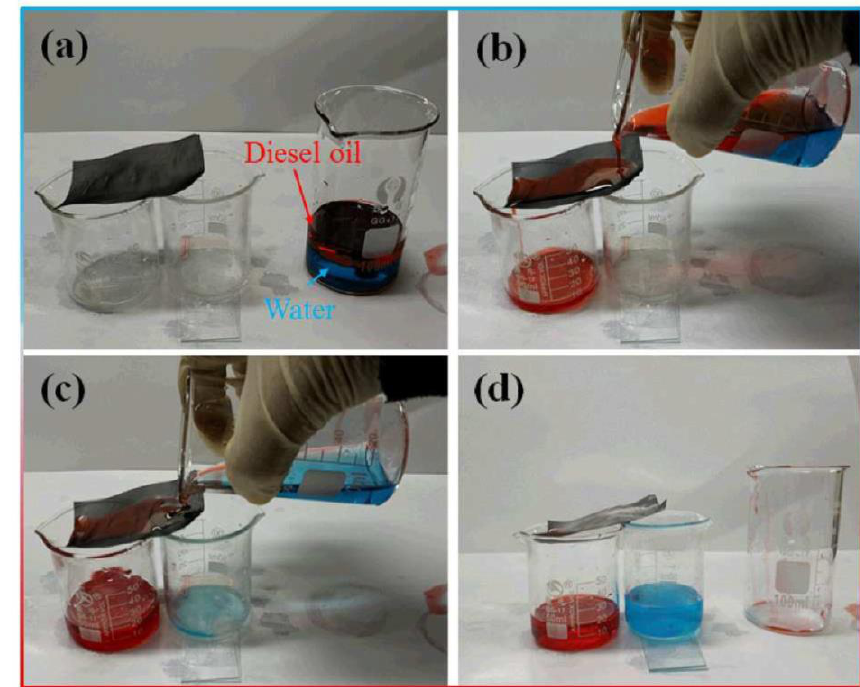
Figure 9. Oil – water separation with a superhydrophilic – underwater superoleophobic FS laser-treated mesh. Contrary to water, oil is repelled, while both the liquids are collected in separate containers [67]. Reproduced with permission from [67] Royal Society of